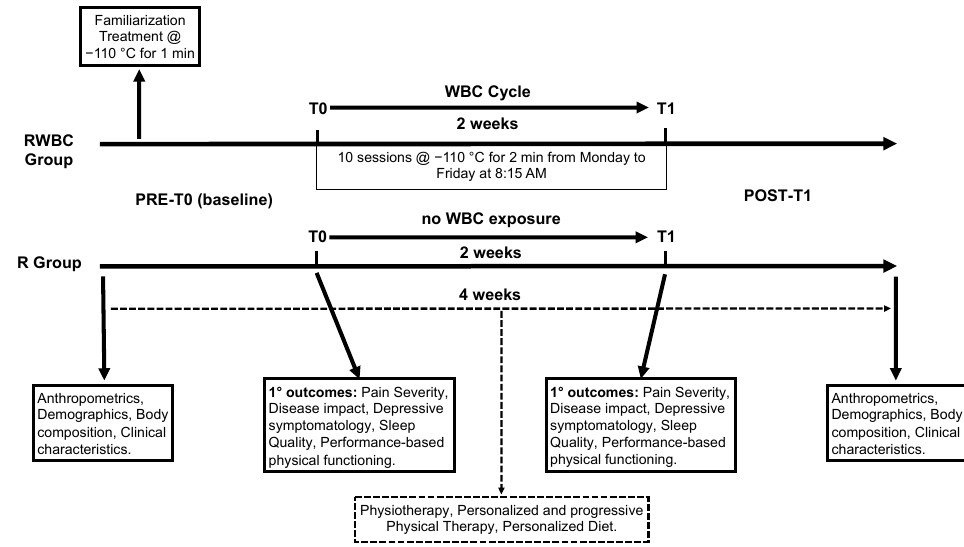
Figure 2. Study design with the timeline of the study protocol, the baseline measures, and the primary outcomes.